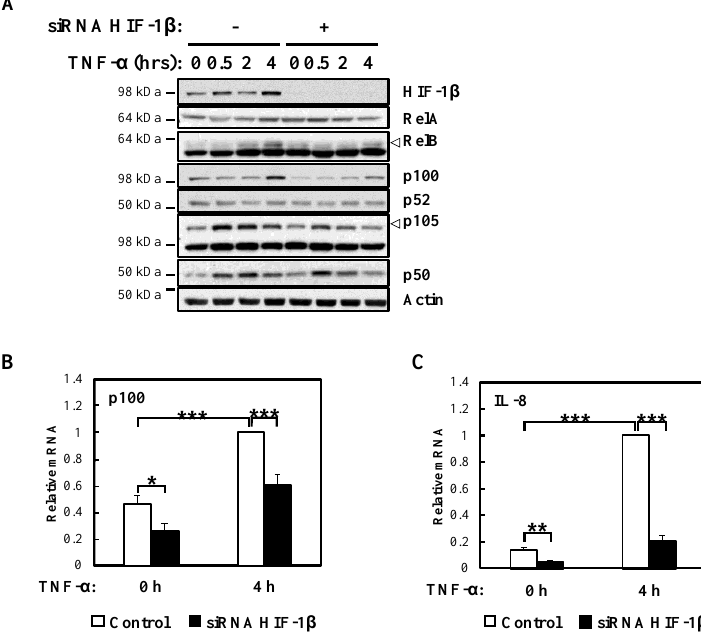
Figure 3. HIF-1 β is required for full NF- κ B activity in response to TNF- α . ( A ) HeLa cells were transfected with control or HIF-1 β siRNA oligonucleotides for 48 h. Where indicated, cells were treated with 10 ng / mL TNF- α for 0.5, 2 or 4 h prior to lysis and Western blot analysis. Actin was used as a loading control. ( B ) HeLa cells were transfected as in 3A , but also treated where indicated with 10 ng / mL TNF- α for 4 h prior to lysis and RNA extraction. Following cDNA synthesis, qPCR was performed using p100 primers. Graphs depict mean and SEM from four independent biological experiments. Student t -test analysis was performed and levels of significance determined as: * p < 0.05, *** p < 0.001. ( C ) HeLa cells were transfected as in 3A , but also treated where indicated with 10 ng / mL TNF- α for 4 h prior to lysis and RNA extraction. Following cDNA synthesis, qPCR was performed using IL-8 primers. Graph depicts mean and SEM from three independent biological experiments. One way ANOVA analysis was performed and levels of significance indicated as follows: ** p < 0.01, *** p < 0.001.